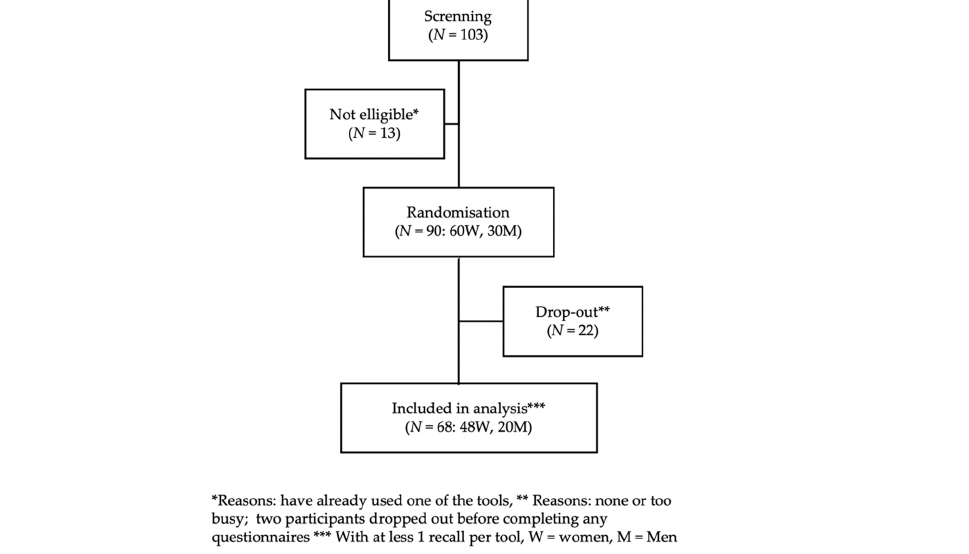
Figure 1. Study flow-chart. Table 2. Sociodemographic characteristics of participants (n = 68) and dropouts (n = 22).